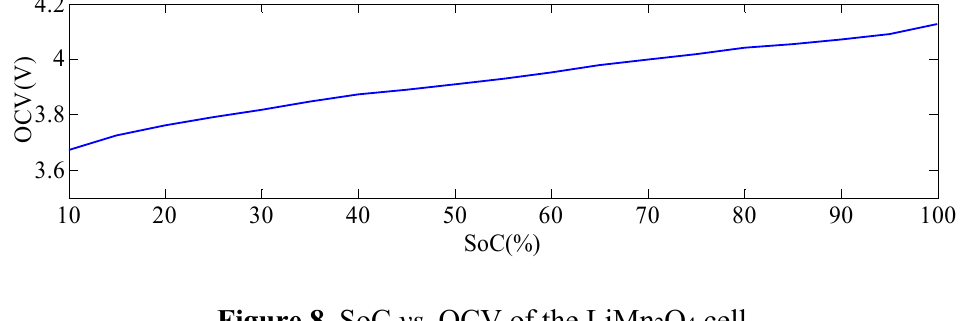
Figure 8. SoC vs . OCV of the LiMn 2 O 4 cell.